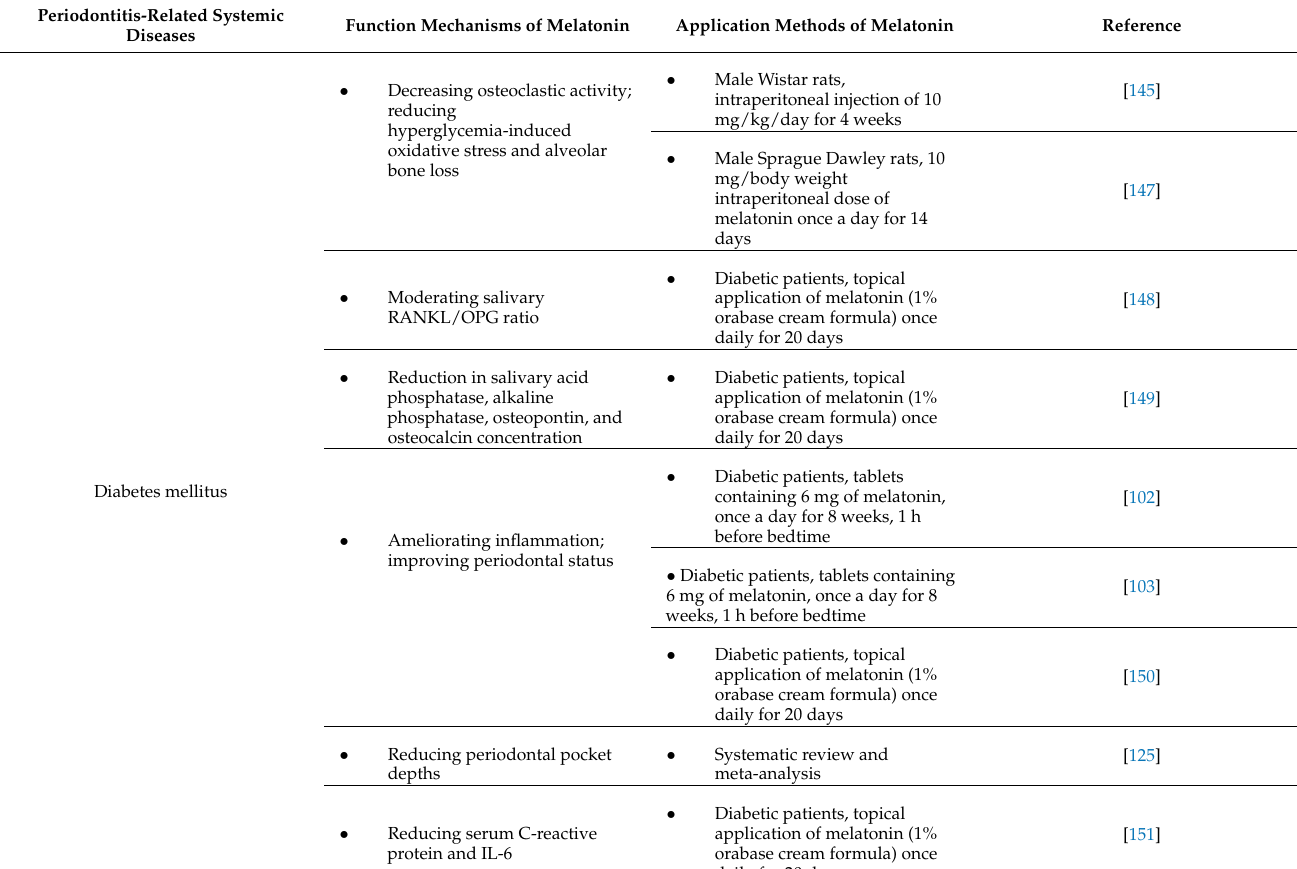
Table 2. Melatonin and periodontitis-related systemic